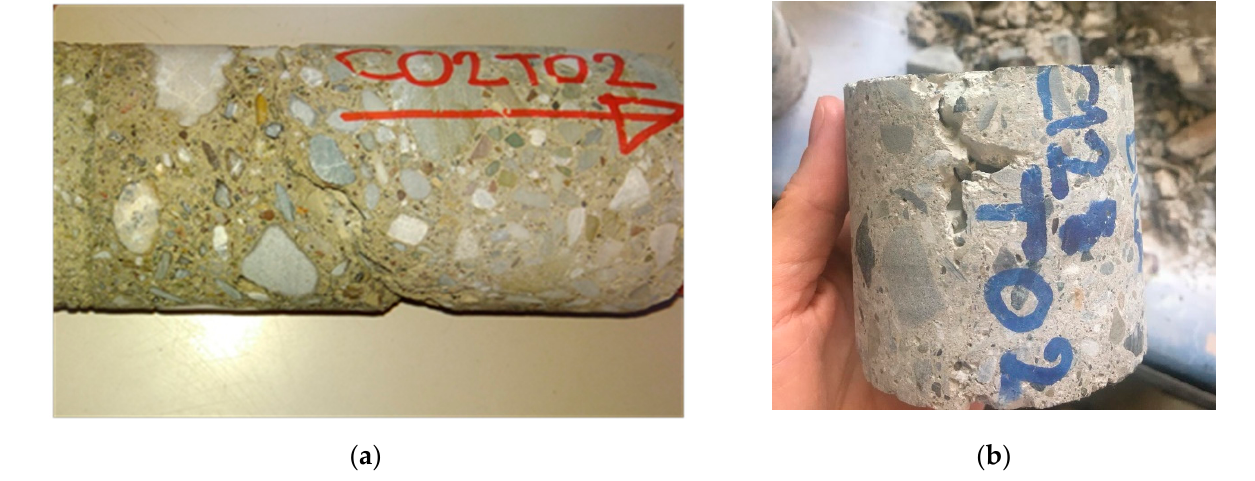
Figure 6. High porosity concrete in extracted samples: ( a ) Column, ( b ) Beam.